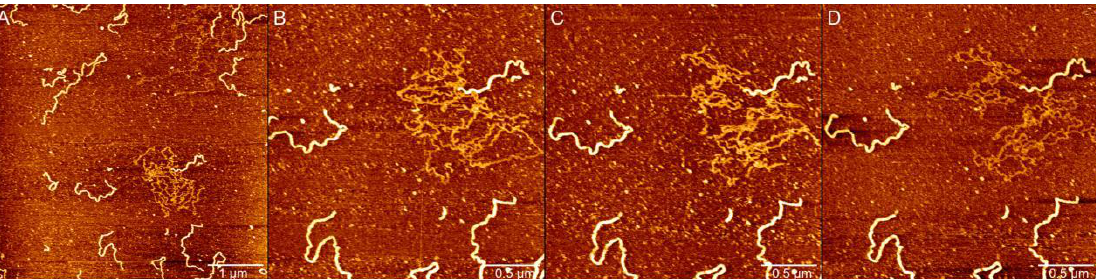
Figure 6. AFM images of 4000 bp linear DNA in deposition buffer (1 mM MgCl 2 , 10 mM HEPES (pH 7.5)) with 300 µM PN. ( A – D ) Images of repeated scanning on the same area for single stranded